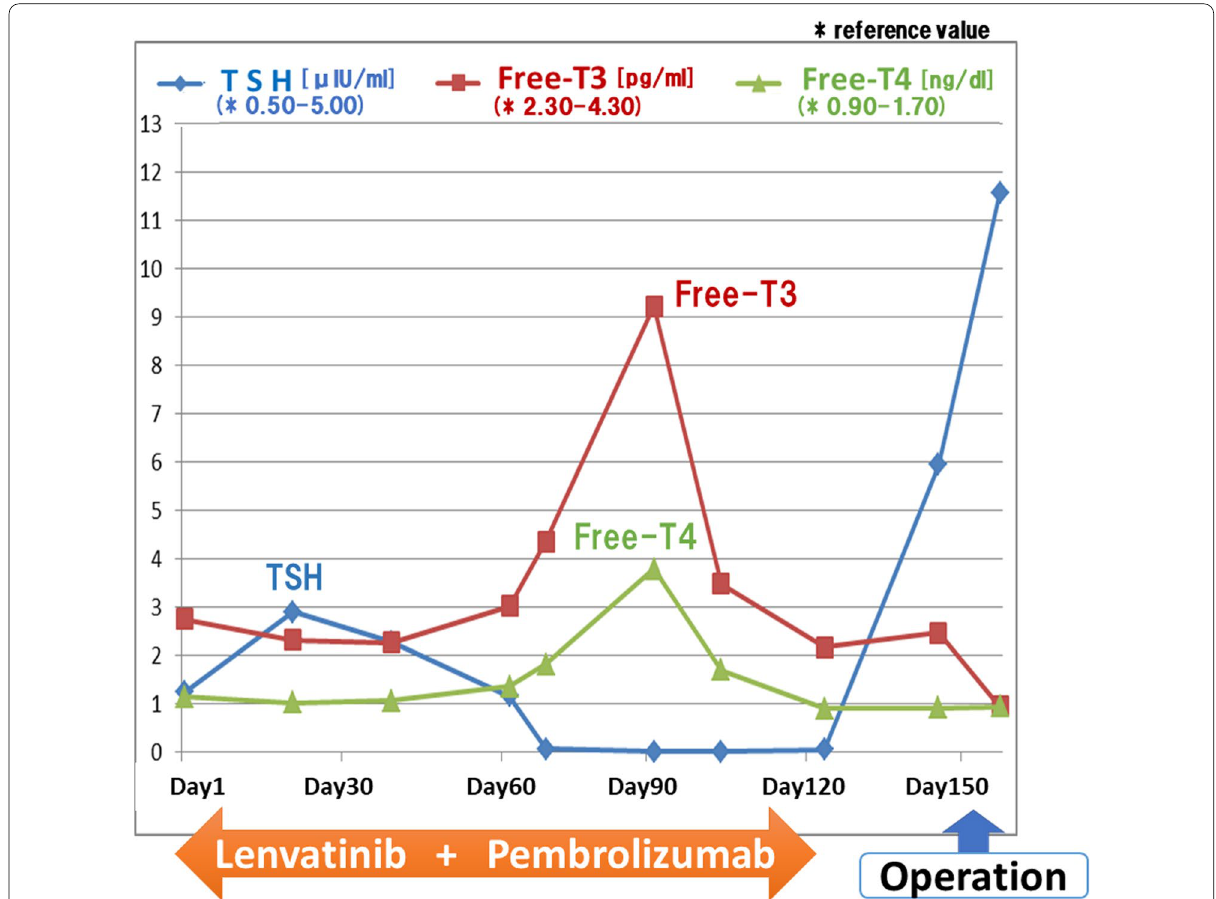
Fig. 3 Transition of Thyroid-stimulating hormone (TSH), Free-T3 and Free-T4 across lenvatinib plus pembrolizumab treatment and